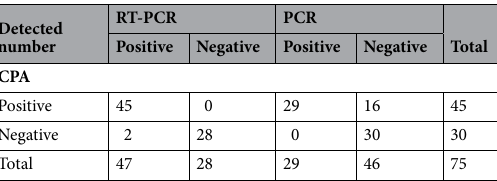
Table 3. Detection results for cell cultures inoculated with clinical plasma with 0.1 ≤ S/P ≤